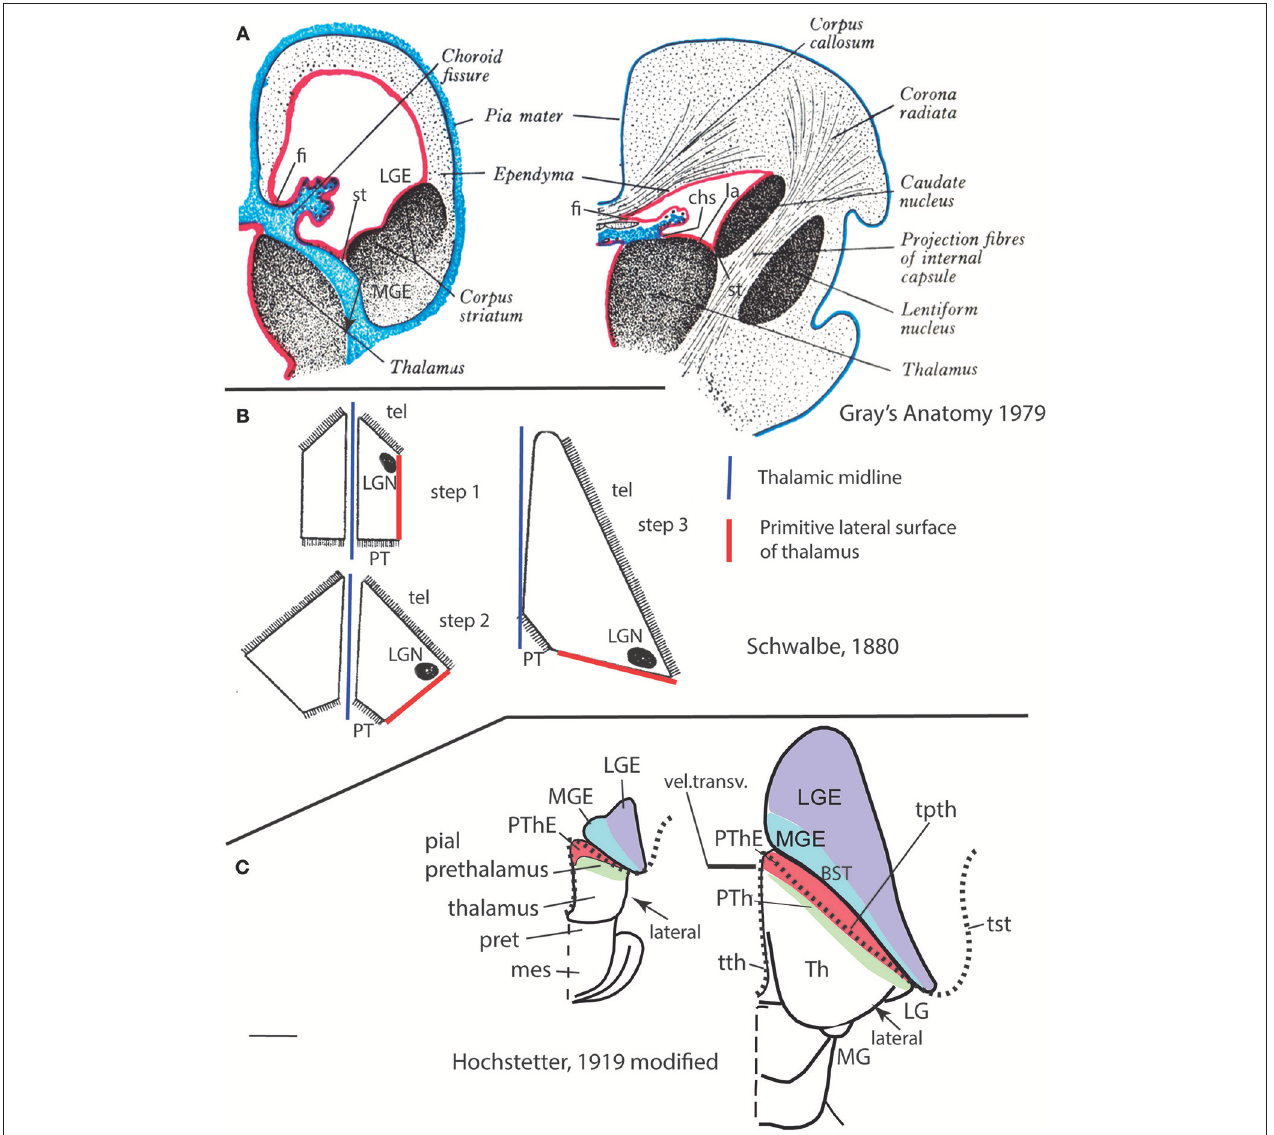
FIGURE 11 | Schematics taken from the literature (all partly modified), to illustrate the classic concept of the lamina affixa (A) , the morphogenetic deformation of the thalamus (B) and my new emphasis on the associated deformations at the prethalamus and prethalamic eminence, bearing on a new conception of the taenial insertions of the chorioidal fissure (C) (no copyright permission required). (A) Was extracted from the 1979 British edition of Gray’s Anatomy. It illustrates precisely how many classic authors imagined a partial adhesion called “lamina affixa” occurred between overlapping parts of the thalamus and the medial wall of the telencephalon (see an equivalent schema in Dèjerine, 1895). A medial part of the hemispheric wall jumping between the hippocampal fimbria (fi) and the stria terminalis locus (st) was supposed to be primarily chorioidal in texture (leaving unexplained how such tissue derives from the roof plate). Only a dorsal part of it, called “pars libera,” was held to contribute to the development of the definitive adult chorioidal fissure (marked as chorioid fissure at left). However, a lower part of the initial chorioid tissue was imagined to adhere to the thalamus, forming the “lamina affixa” (la; at right). The figured classic conception is conjectural, since it holds without demonstration that one half of the primary medial telencephalic wall adheres to upper and lower parts of the thalamic pial surface. The chorioid-thalamus adhesion (la) would obscure the original chorioidal taenia imagined as inserted primarily next to the prospective stria terminalis (st), creating an apparently novel “thalamic taenia” of the chorioidal fissure at the so-called chorioidal sulcus of the thalamus (chs; right side; note there is already a thalamic taenia associated to the roof of the 3rd ventricle). The stria terminalis site was originally held to be associated to the “corpus striatum” [meaning the whole mass of basal ganglia; we now know the st is associated specifically to the lateral ganglionic eminence (LGE; left side), whereas the pallidum and diagonal formations, including the periventricular bed nuclei of the stria terminalis, are derivatives of the medial ganglionic eminence (MGE; left side); see Puelles et al., 2013, 2016]. After the conjectured fusion, the part of the upper thalamic surface covered by the chorioid lamina affixa would apparently protrude at the floor of the lateral ventricle, forming with the medial ganglionic eminence the “terminal” or “opto-striatal” sulcus, a.k.a. as “thalamo-striatal” sulcus. Another imagined adhesion process with consequences was that of the primary lateral thalamic pial surface with the “corpus striatum,” which would allow the thalamic fibers to reach the internal capsule (right side of A ; this second conjecture was supported expressly by Dèjerine (1895), but is no longer widely supported presently, since the internal capsule fibers are now known to course first internally through the